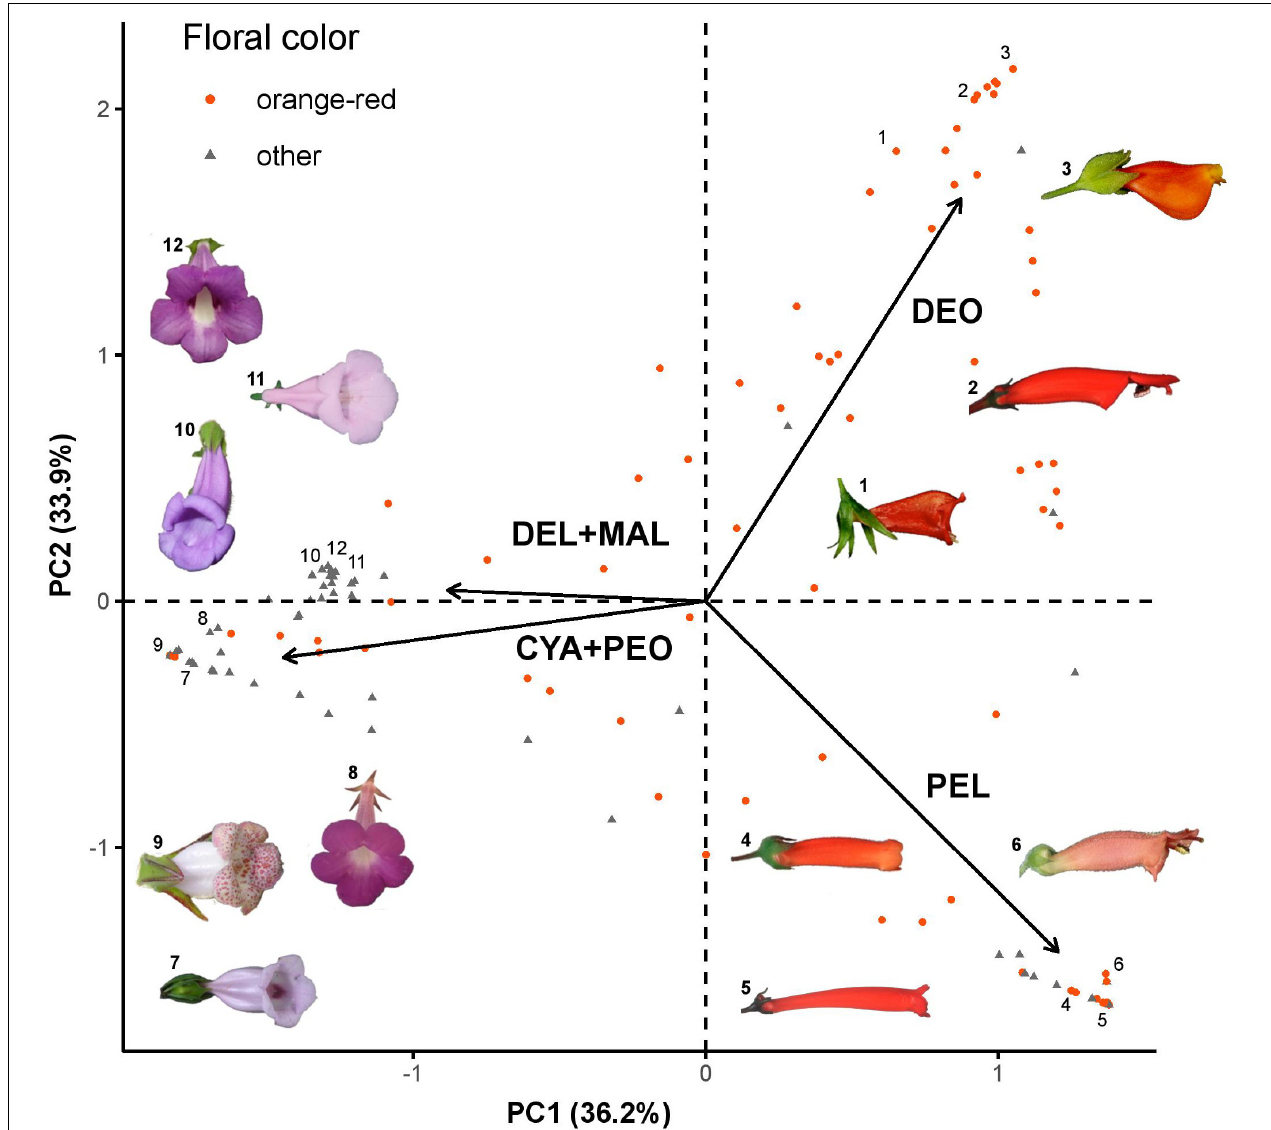
FIGURE 2 | PCA plot of Gesnerioideae flowers based on their anthocyanin composition. Arrows represent 4 loadings: PEL, pelargonidin; CYA+PEO, cyanidin and peonidin; DEL+MAL, delphinidin and malvinidin; DEO, deoxyanthocyanin (luteolinidin and apigenidin). Orange/red flowers are shown as orange dots, flowers with other colors are shown as gray triangles. 1: Nematanthus crassifolius , 2: Sinningia glaziovana , 3: N. strigillosus , 4: S. aggregata , 5: S. gigantifolia , 6: S. elatior , 7: Paliavana tenuiflora , 8: Achimenes grandiflora , 9: N. whieleri , 10: S. sp. nov.1 , 11: S. eumorpha , and 12: S. speciosa